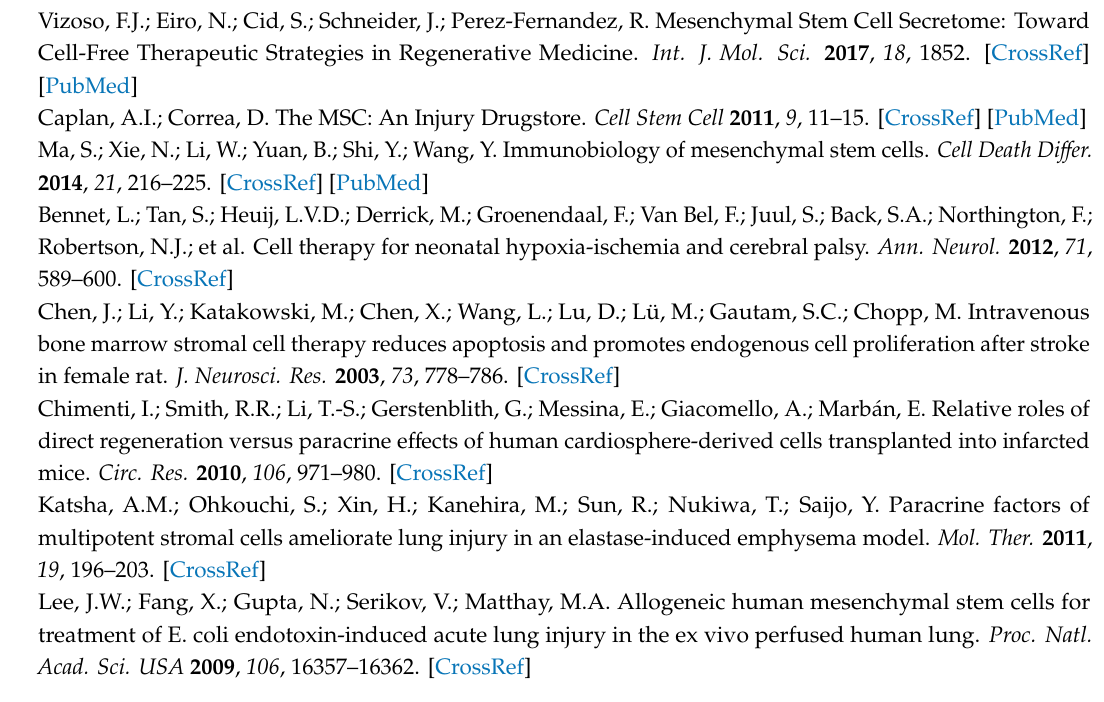
Figure S1: MSC profile by cytometry after conditioning for 48 h in proliferative media with 20% FBS. Figure S2: MSC profile by cytometry after conditioning for 48 h in medium with 20% EV-depleted FBS. Figure S3: MSC profile by cytometry after conditioning for 48 h in medium without FBS. Figure S4: Representative bright-field images of MSCs in culture under all conditions. Figure S5: EV markers on UC, UC w / o , EV, EV w / o , Prot and Prot w / o samples and cell lysates. Figure S6: Presence of proteins and EV marker in SEC fractions collected from UC and UC w / o samples. Figure S7: Total protein quantification of SEC fractions collected from UC and UC w / o